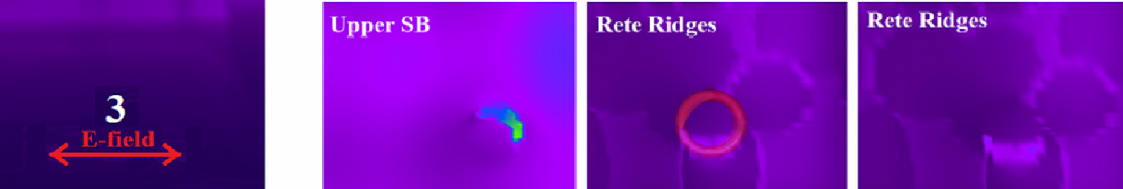
Figure 5. Simulations of SAR surrounding sweat ducts in thin skin. The duct (1) represents a sweat duct containing 1001 Sm − 1 sweat, duct (2) contains 10,014 Sm − 1 sweat and duct (3) is filled with “physiological” conductivity sweat of 105 Sm − 1 . ( A ) Vertical cross-section, direction of the polarized H-field as shown (E-field is into the page) SAR. Left panel showing the general position of the sweat ducts and the Stratum Basale. There are minor differences in the distribution of SAR in the ducts containing “high electrical conductivity sweat” of 10,014 Sm − 1 and 1001 Sm − 1 . The left edge of the duct containing the “physiological” sweat (105 Sm − 1 ) is barely discernible. ( B ) “Physiological” sweat containing a duct, vertical section, the E-field as shown, polarization at 90 ◦ to the direction in ( A ). ( C ) Horizontal cross-sections, “physiological” sweat containing duct, at 0.12 mm depth (the level of the Stratum Basale) and at 0.16 mm (deeper at the rete